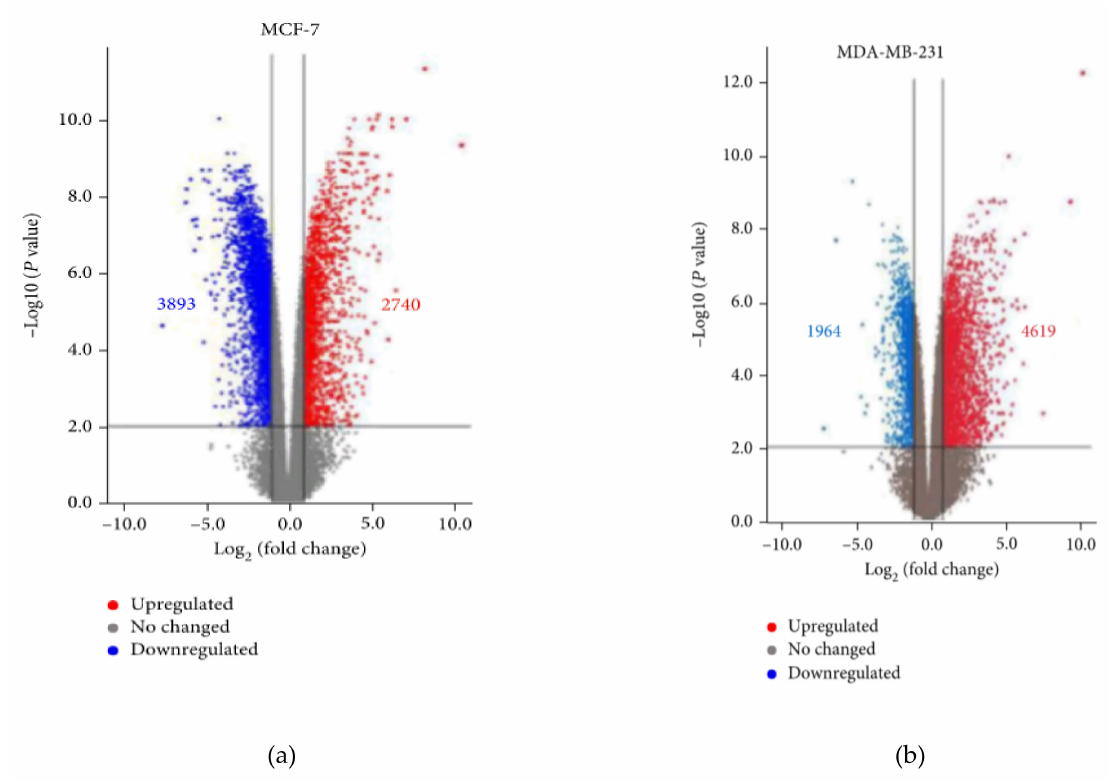
Figure 14. Differential expression hierarchical clustering analysis ( a ) Volcano plots of the transcrip- tion levels of genes in control and 40 µ M curcumin-treated MCF-7 cells. ( b ) Volcano plots of the transcription levels of genes in control and 40 µ M curcumin-treated MDA-MB-231 cells (Figure 14 is taken from the work R. Li